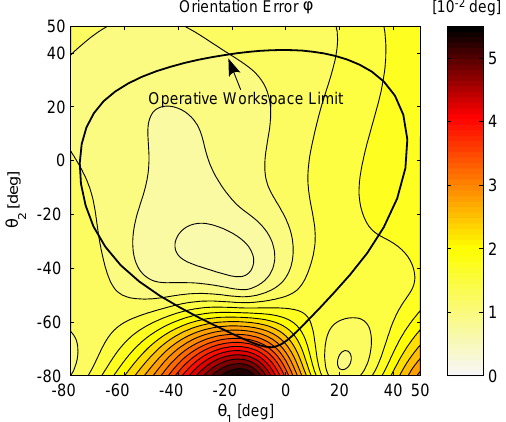
Figure 6. Orientation error φ of the MP mapped in the joint space.